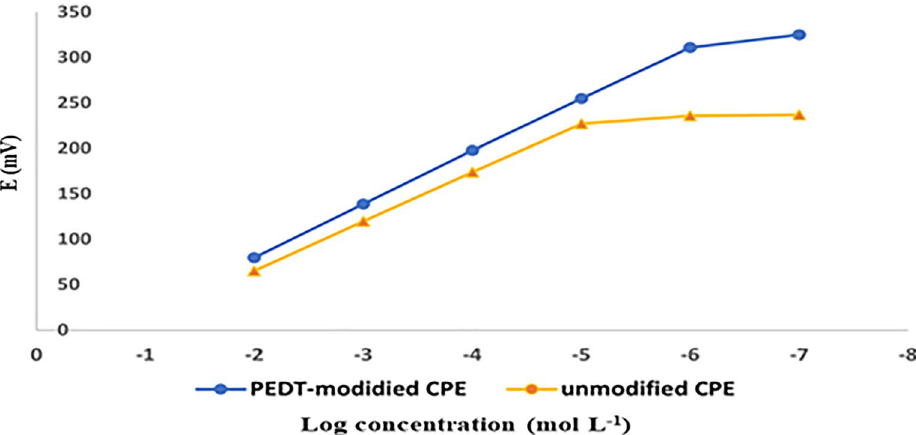
Figure 3. Potential profile (in millivolts) to the logarithm of concentrations of probenecid (1.0 × 10 −7 – 1.0 × 10 −2 mol/L) using PEDT-modified CPE and unmodified